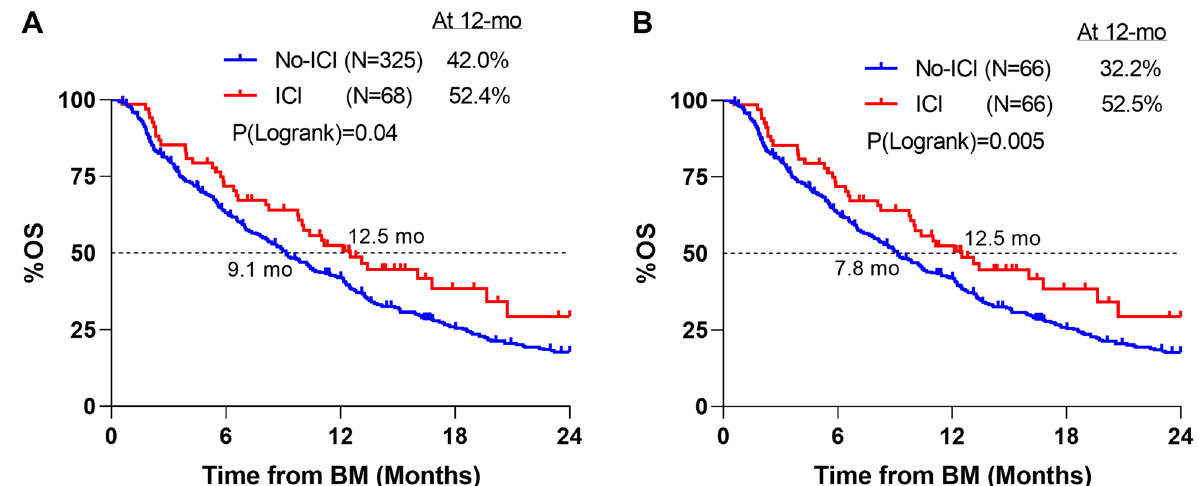
Figure 2. ( A ) Overall survival comparing ICI-90 to no-ICI with the exclusion of patients who received surgery for brain metastases. ( B ) After a Greedy match was performed to balance the ICI-90 and no-ICI cohort after the removal of patients with intracranial surgery, overall survival from the diagnosis of brain metastases is graphed. Log-rank test was